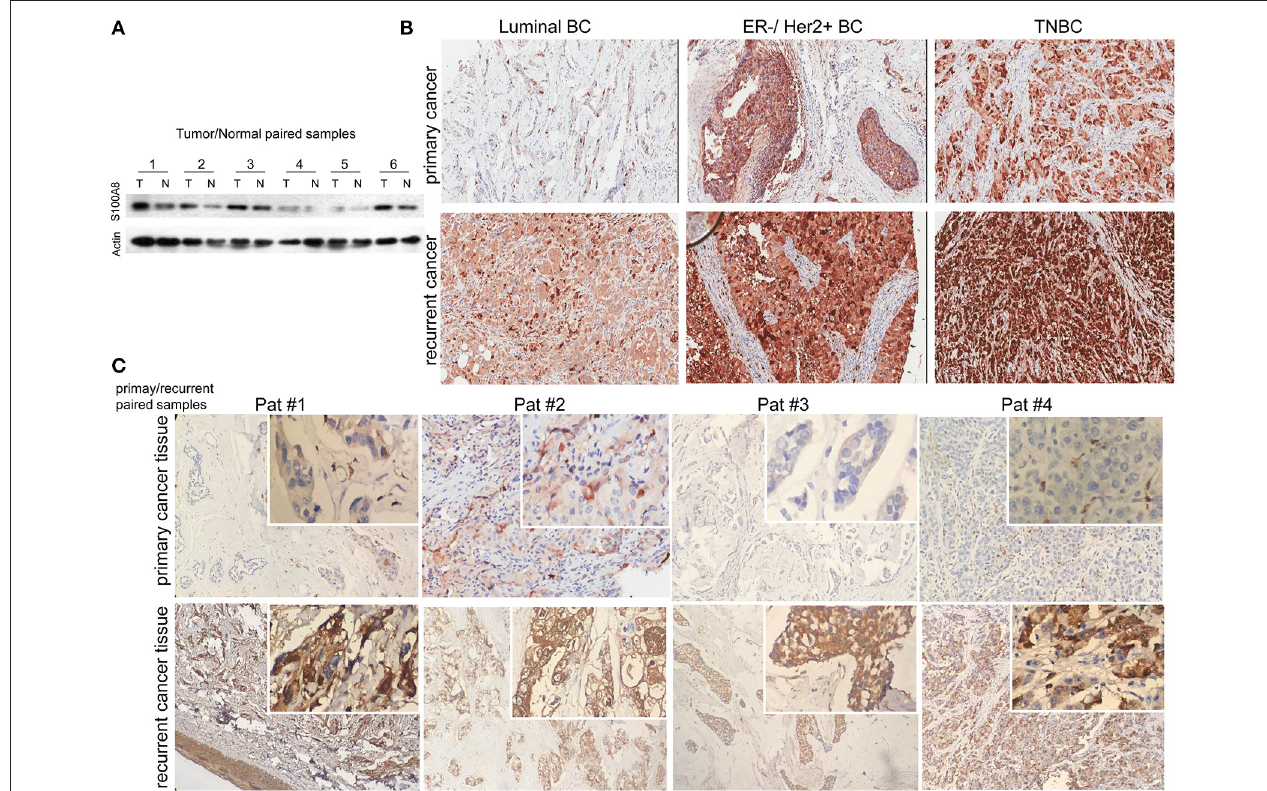
FIGURE 2 | Immunohistochemical analysis of S100A8 expression in different subtypes of breast cancer tissue samples. (A) Western blots of paired samples of tumor tissue (T) and non-neoplastic breast tissue (N) immunoblotted against S100A8 or β -actin (used as a loading control). (B) IHC staining for S100A8 expression in primary (top) and recurrent (bottom) breast cancer tissue samples: luminal breast cancer (left), ER-negative and HER2-positive breast cancer (middle), and TNBC (right). (C) IHC analysis of S100A8 expression in primary/recurrent paired samples.